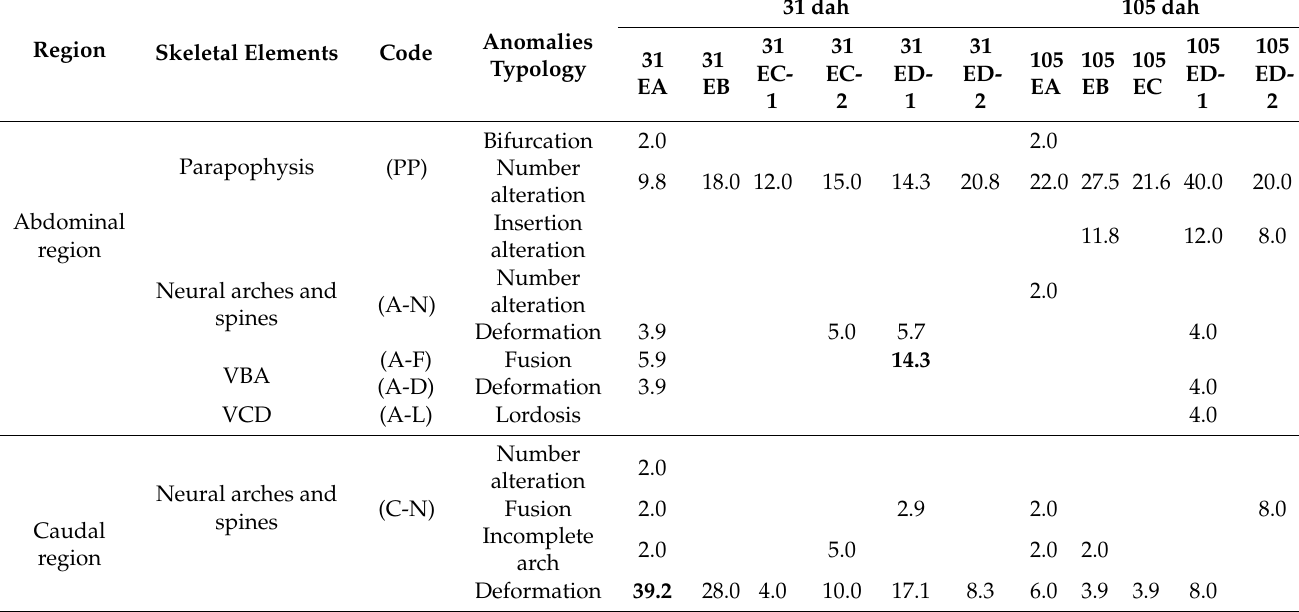
Table 10. Relative frequency (%) of affected individuals by each anomaly type (categories code name is between parenthesis) for each group (31 EA, 31 EB, 31 EC-1, 31 EC-2, 31 ED-1, 31 ED-2, 105 EA, 105 EB, 105 EC, 105 ED-1, 105 ED-2). Empty cells denote a frequency equal to zero (0). Bold values denote some typologies more frequent or predominantly present in a specific diet-tank group. dah: days after hatching; VBA: vertebral body anomalies; VCD: vertebral column